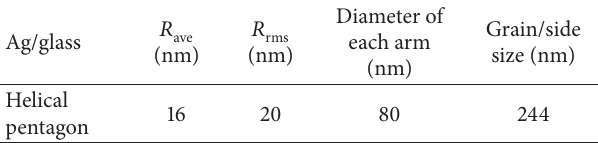
Table 1: Average surface roughness and grain size for helical pentagon silver sculptured thin films.